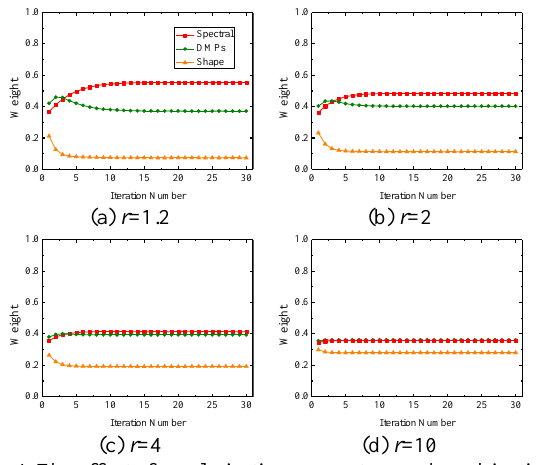
Fig. 4. The affect of regularization parameter r and combination weights in each